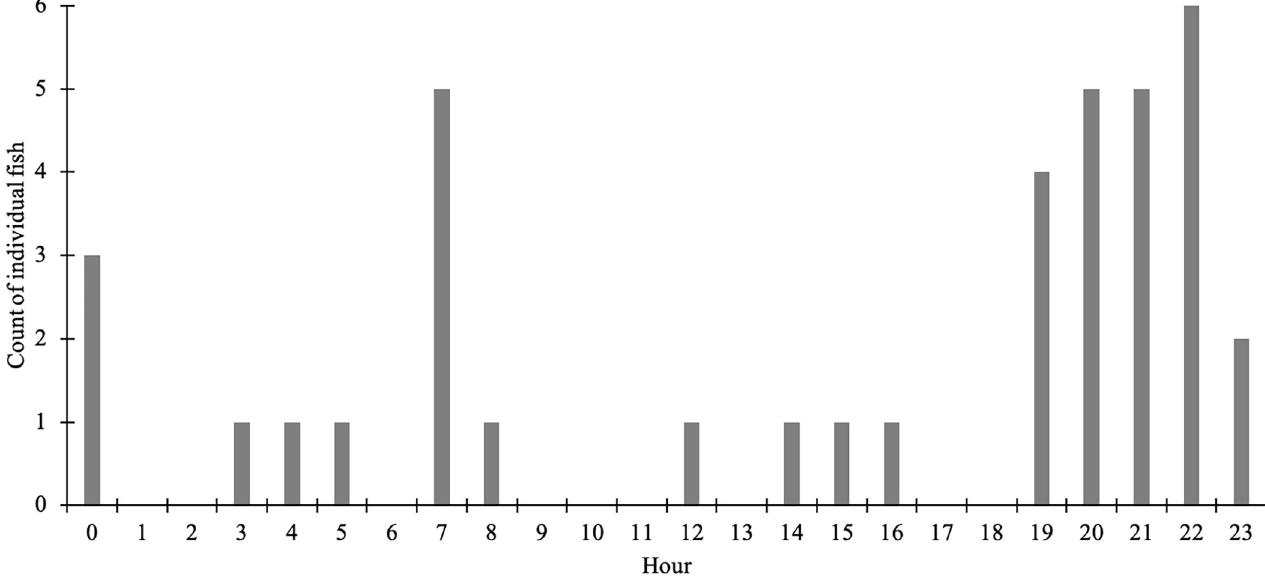
Fig 6. The hourly timing of movement of juvenile steelhead trout across the BDA in 2016. The 2016 experimental release, showing the hourly timing of tagged juvenile steelhead trout detected moving past BDA 1 during the 4-day experiment (n = 38 of 58 released). Most of the fish moved during the late evening, after sunset (sunrise = 07:08 and sunset = 18:55 on